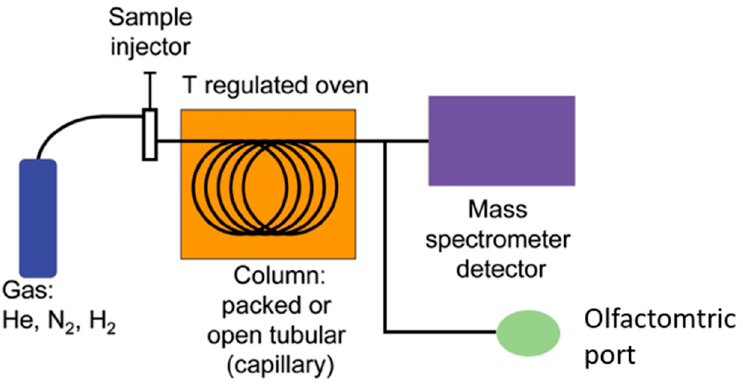
Figure 3. Gas chromatography analysis with olfactometric detection (GC-O)